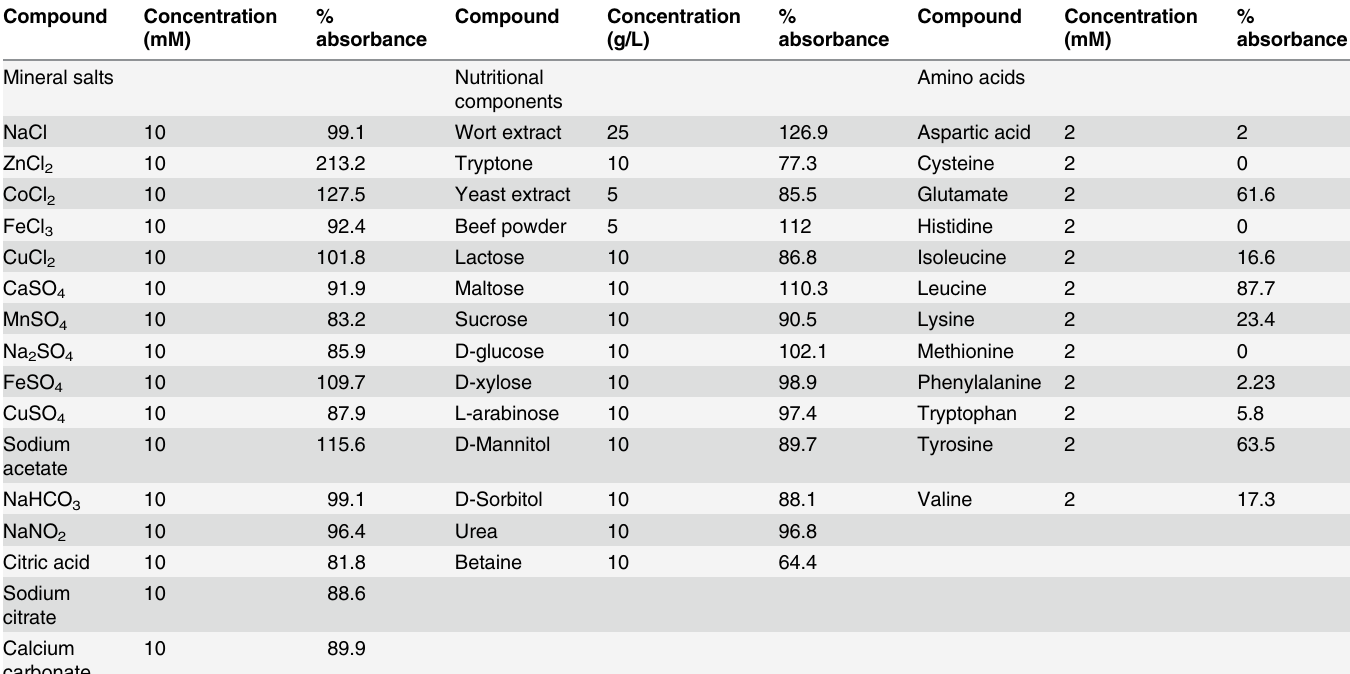
Compound Concentration % (mM) absorbance